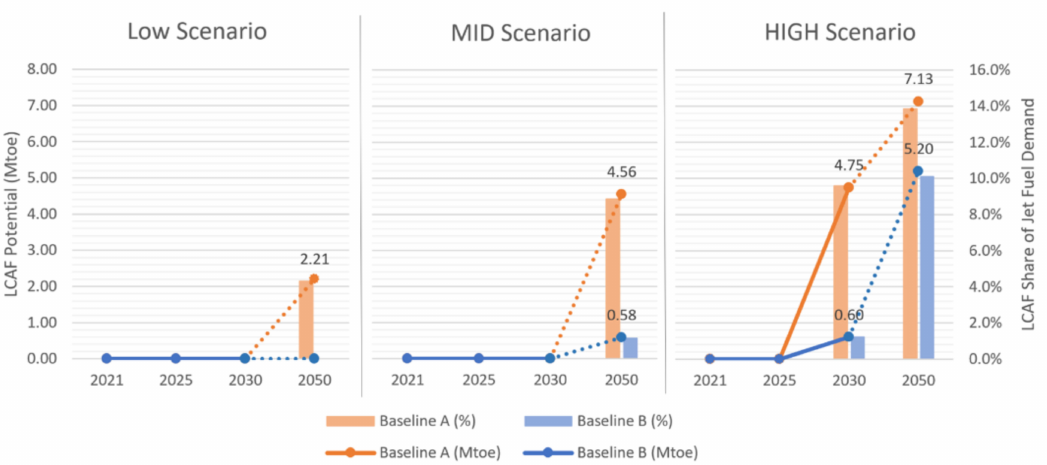
Figure 4. LCAF technical potential at EU-27 level and corresponding share of total energy demand for aviation. Calculated using free-allocation method.